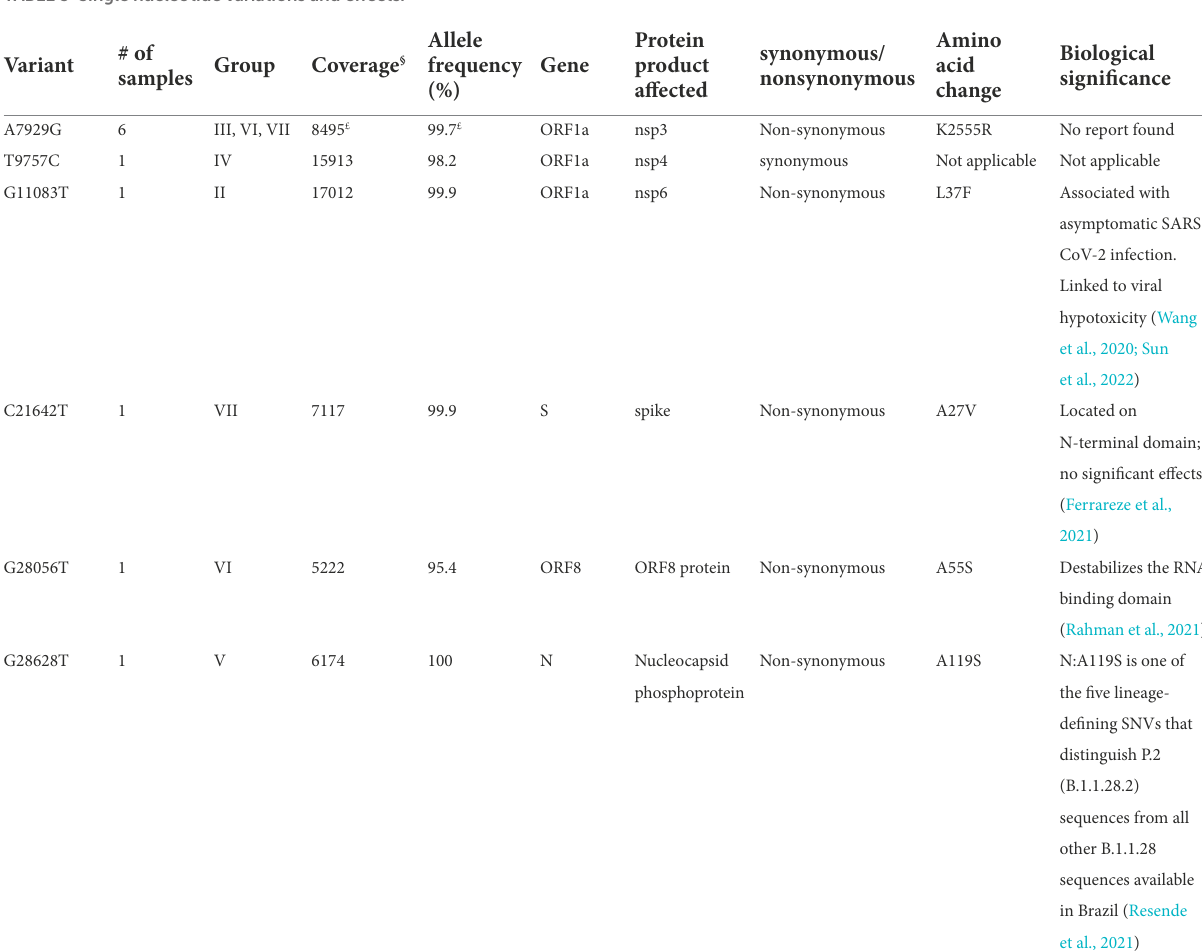
TABLE 3 Single nucleotide variations and